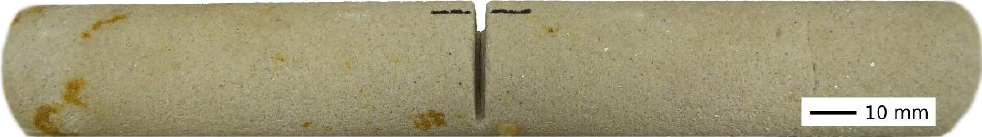
Figure 2. The ruptured specimen after the in-situ loading.